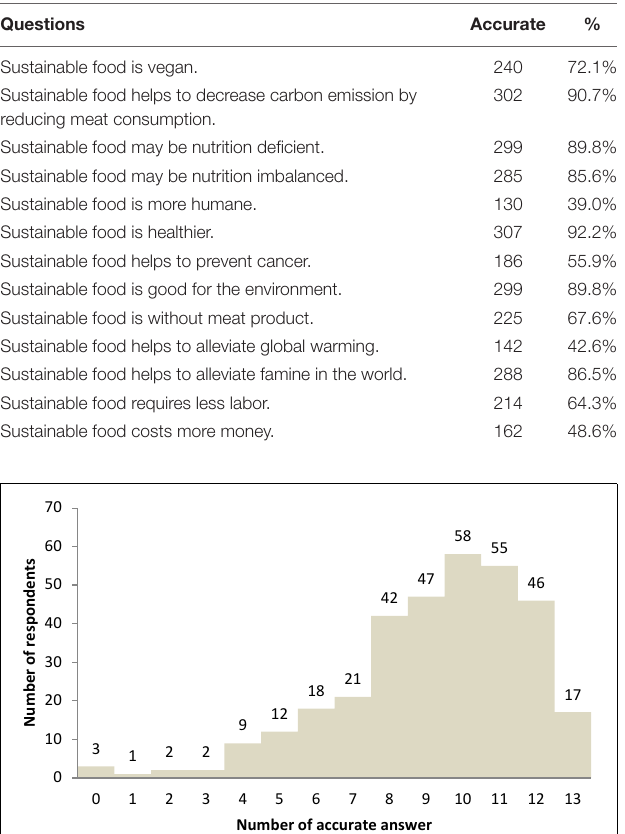
TABLE 3 | Questions to assess respondents’ level of knowledge.